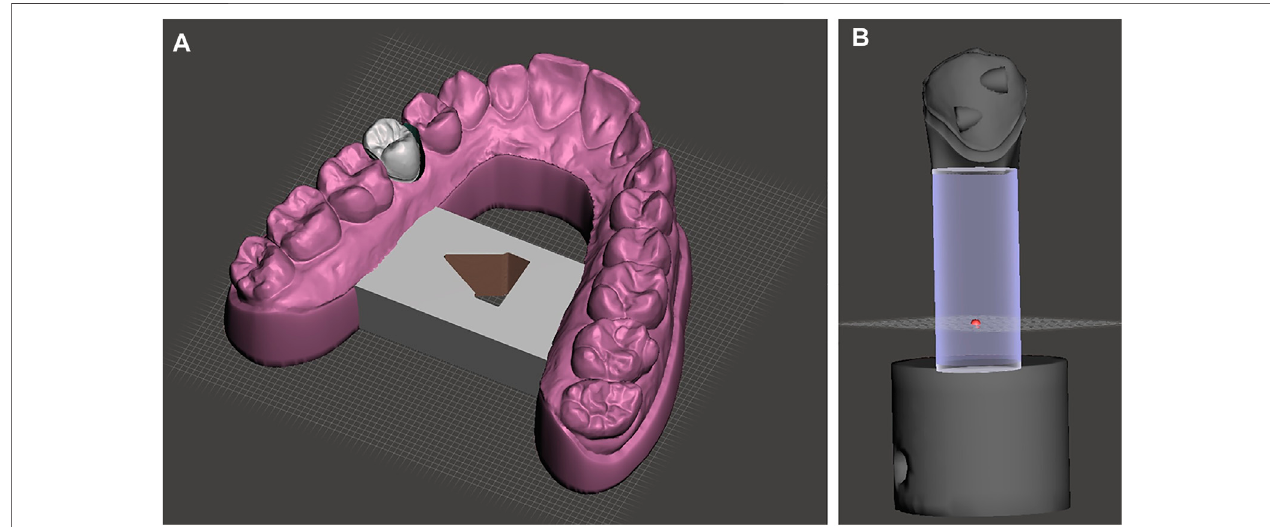
FIGURE 1 | 3D design of the set up. (A) . Model base used for all tests (in purple) and the test tooth 15 fi tted with the various attachments (grey). Please, note the clearance around test tooth 15, which allowed for freerotation around the tooth longaxis, without any interference. (B) . All the setups oftooth 15with thedifferenttypes of attachments were built on the same base tooth model and had the same cylindrical base. Here, the ElliPair attachment (consisting of two hemi-elliptical attachments, HemiElliR and HemiElliL) are depicted.